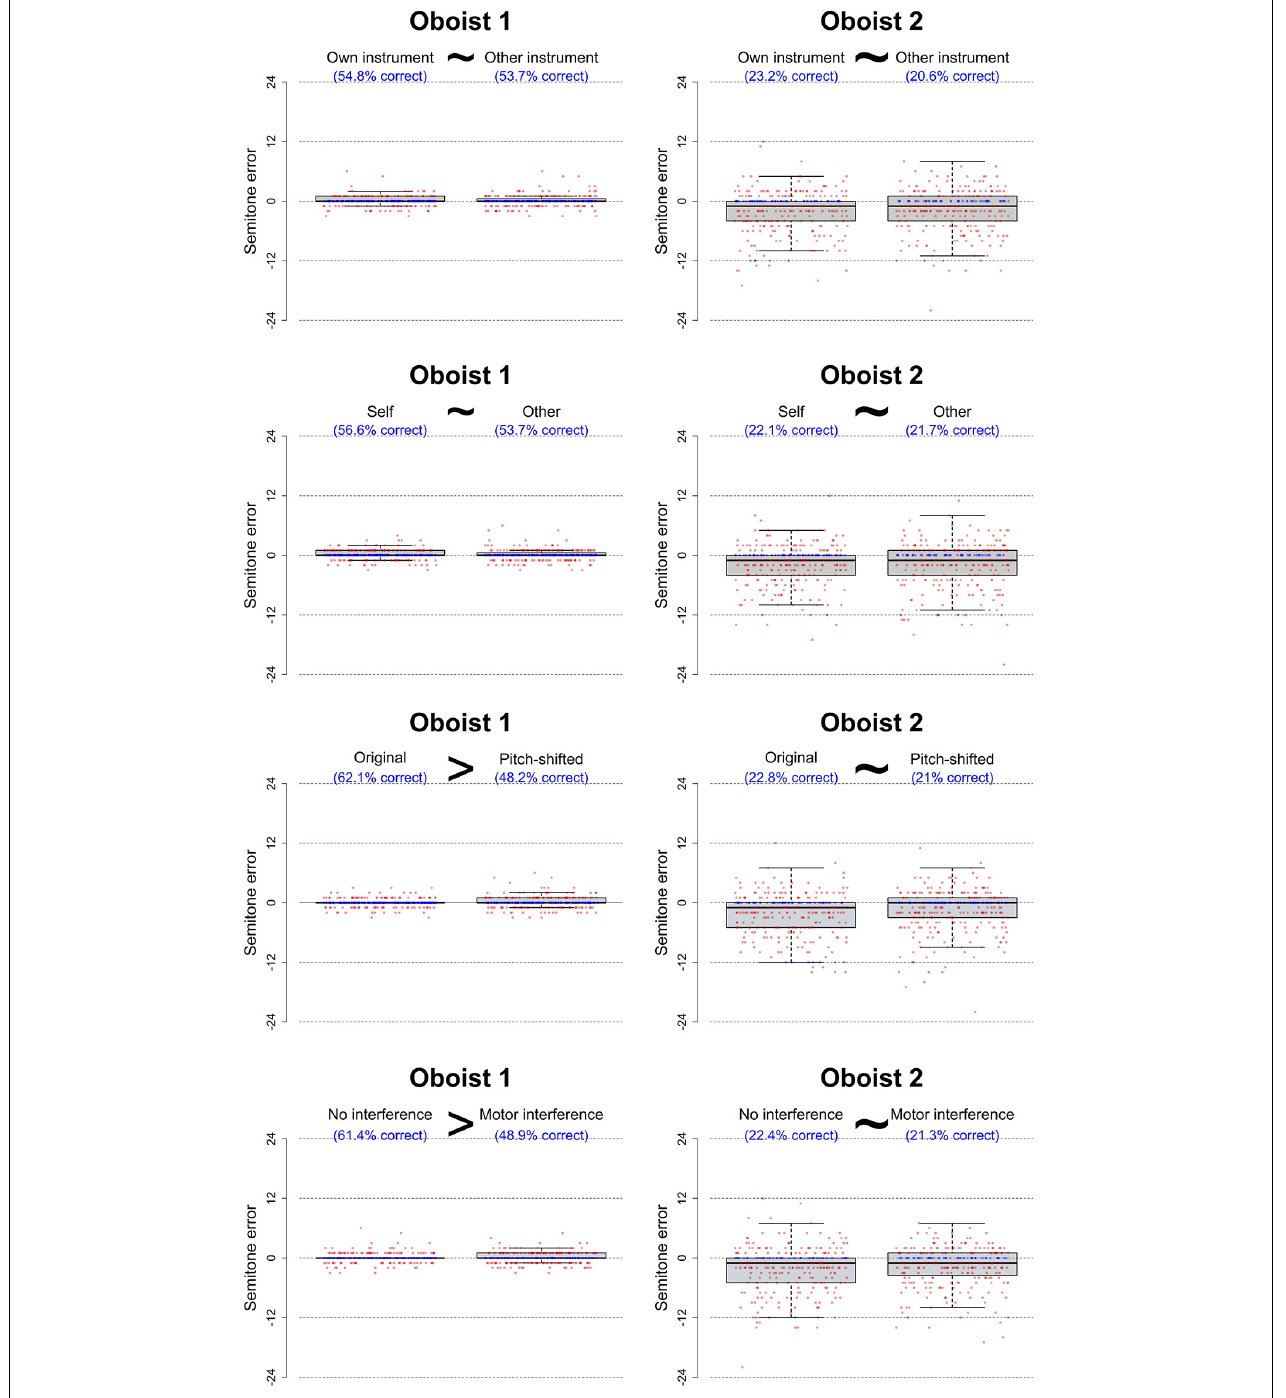
FIGURE 5 | Boxplots with raw data of response deviation (in semitones) from the target pitch for correct (blue) and incorrect (red) pitch identification responses provided by the two oboists during Experiment B. The four sub-panels contain data from the four experimental manipulations: instrument (own instrument vs. other instrument), performer (self vs. other), transposition (original vs. pitch-shifted), and motor interference (no interference vs. motor interference). Percentage of correct responses in each condition is indicated in blue writing, and the box plots depict the number of semitones that responses were off from the target. The presence and direction of significant differences between conditions—as assessed with logistic regression modeling—are indicated with “ > ” signs whereas “ ∼ ” indicates that the relevant factor did not contribute significantly to the prediction of correct responses. As can be seen, whereas Oboist 2’s performance was not affected by any of the experimental manipulations, the use of pitch-shifted stimuli and the motor interference task decreased Oboist 1’s ability to correctly identify absolute pitch for oboe tones as well as increased the number of semitones that her responses were off from the target pitch.